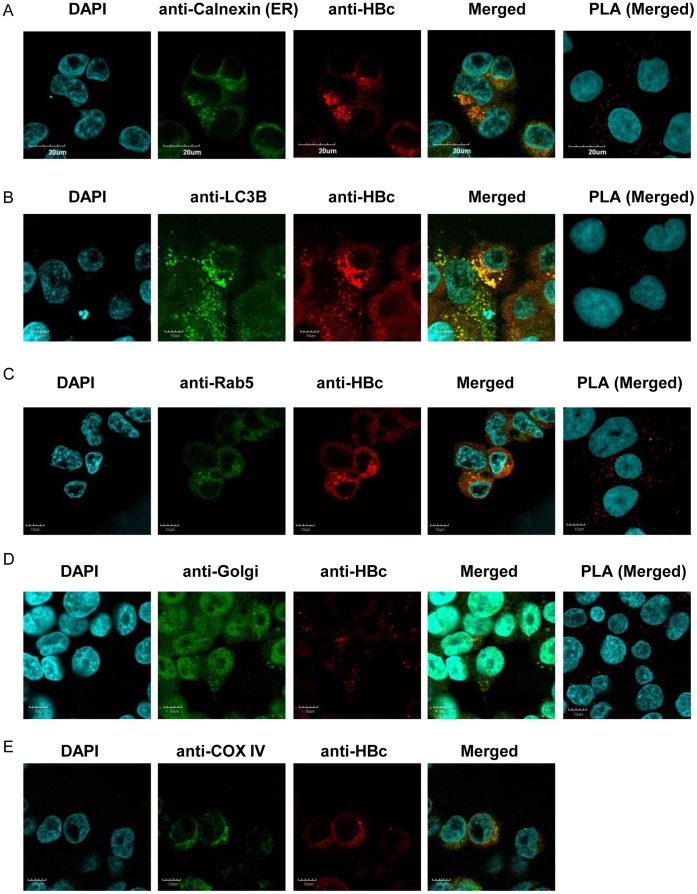
Interactions between HBc and HBs.A) Co-localization of anti-HBc and anti-Calnexin staining by immunocytochemistry and PLA analysis indicate that HBc probably localizes in the ER. Overlap with B) anti-LC3B, C) anti-Rab5, and D) anti-Golgi staining suggests that HBc probably also localizes in autophagosomes, endosomes, and Golgi, respectively. E) However, no overlap was observed with anti-COX IV staining, indicating that HBc probably does not localize at mitochondria.